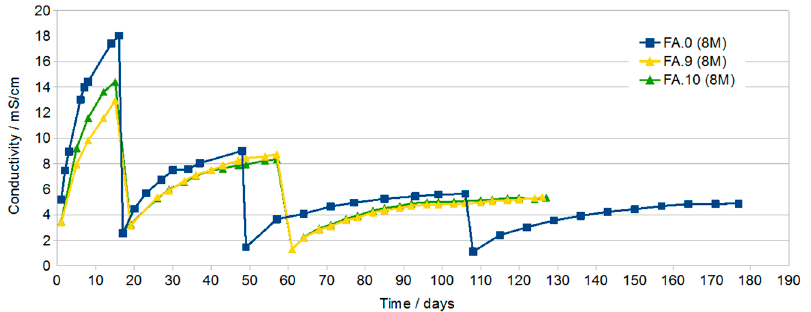
Figure 3. Of samples FA.0 (8 M), FA.9 (2% G70), and FA.10 (4% G70) as a function of immersion time with periodic water changes.